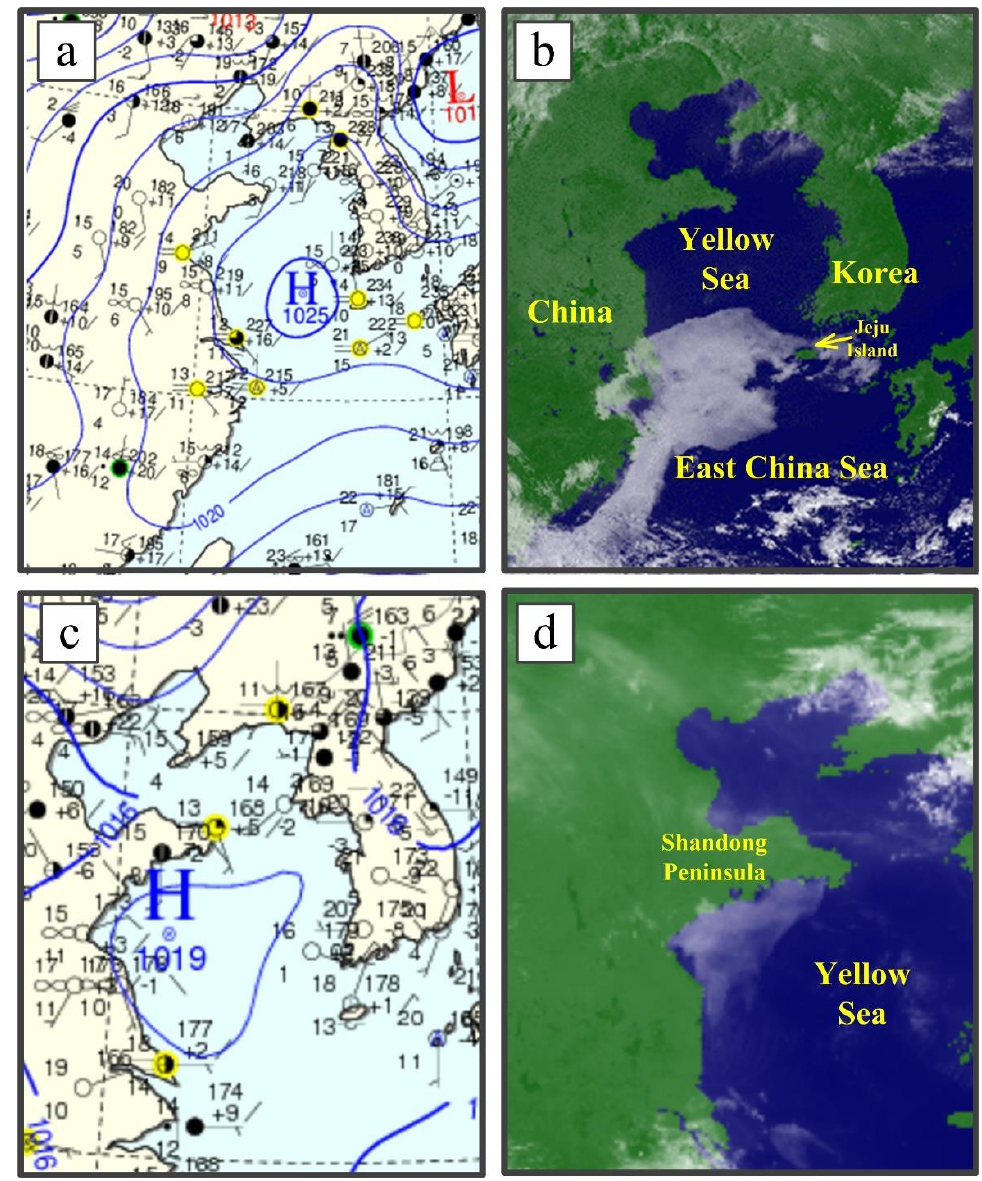
Figure 1. Korea Meteorological Administration (KMA) surface synoptic charts ( a , c ) and Multifunctional Transport Satellite (MTSAT) visible satellite images ( b , d ). Upper panels ( a,b ) are the case C-09 at t at 0000 UTC 10 April 2009, and lower panels ( c,d ) are for the case C-14 at 0300 UTC 2 April 2014.